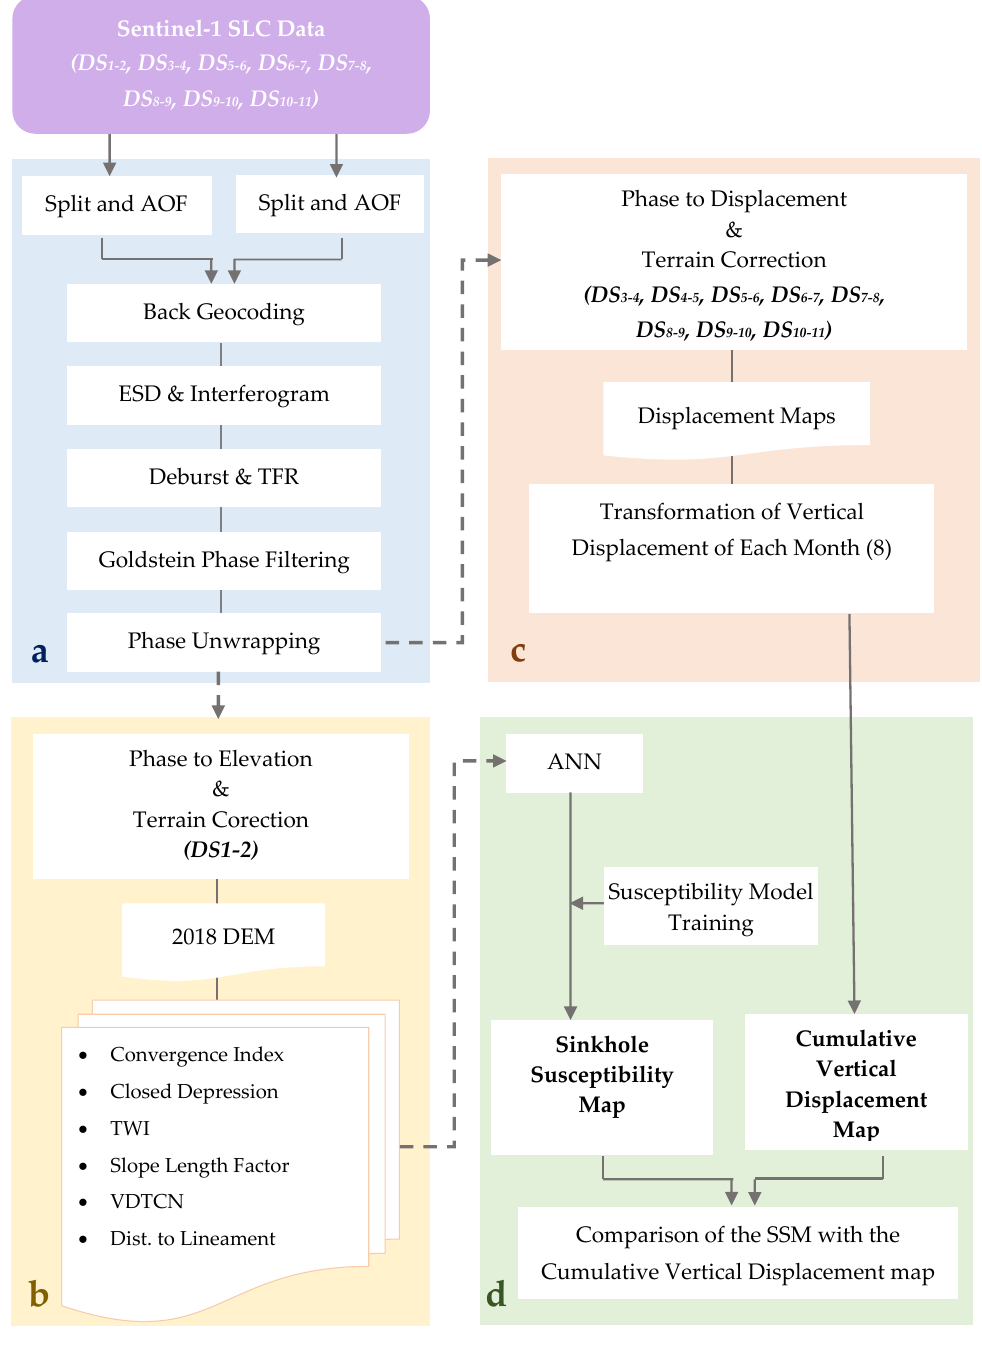
Figure 6. The detailed methodological workflow of the study (AOF: Apply Orbit File, ESD: Enhanced Spectral Diversity, TFR: Topographic Phase Removal). ( a ) Pre-processing of SAR datasets; ( b ) DEM generation and feature extraction; ( c ) deformation map production; and ( d ) sinkhole susceptibility map production and validation.